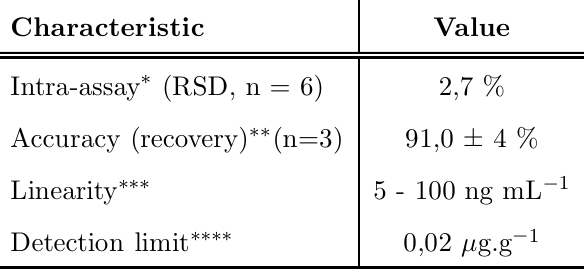
Table 1 Method characteristics for Imazalil ¤ - repeated injection of the same apple extract; 50 ng of IMZ mL ¡ 1 ¤ ¤ - apple spiked with 0.5 · g of IMZ.g ¡ 1 ¤ ¤ ¤ - correl. coe¬ =